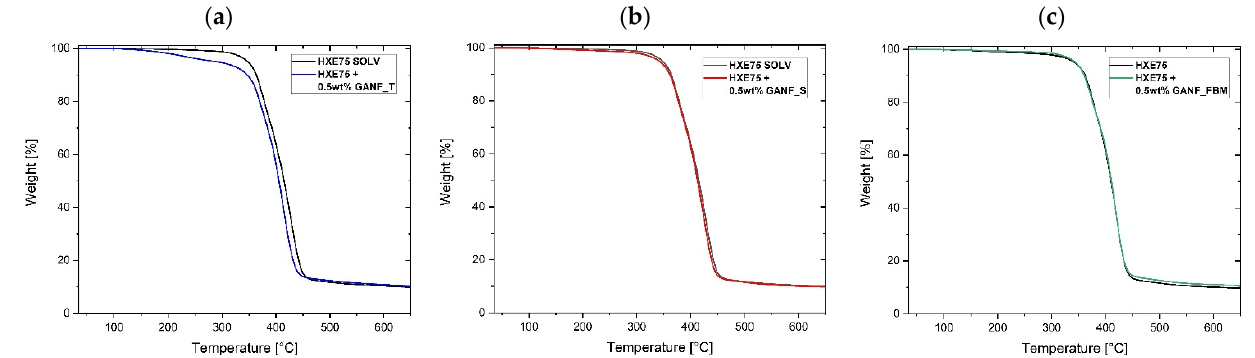
Figure 7. TGA of the neat epoxy matrix and the GANF based nanocomposites. ( a ) HXE75 + 0.5 wt% GANF_T. ( b ) HXE75 + 0.5 wt% GANF_S. ( c ) HXE75 + 0.5 wt% GANF_FBM.